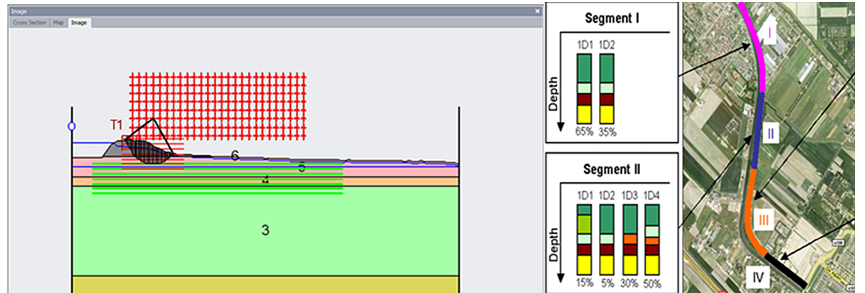
Figure 3. Input and results DAM-calculations. The figure shows one cross-section, representing Segment II for which – statistically – a distribution of possible geological settings is estimated. The grid represents all possible slip circlesof which the most critical is established by calculating them